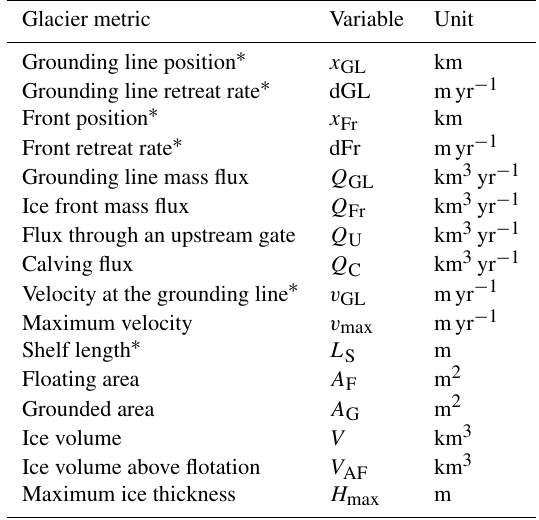
Table 3. Glacier characteristics assessed during retreat for later cor- relation with fjord geometry. Parameters marked with ∗ are assessed along the central flow line of the